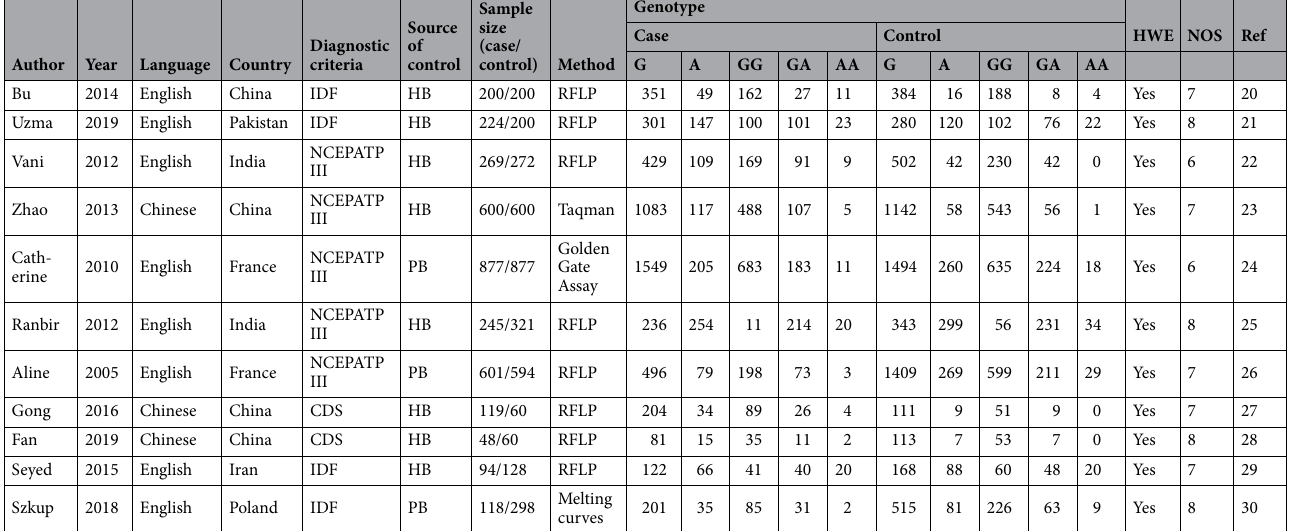
Table 1. General characteristics of studies included in the meta-analysis. HB hospital based, PB population based, IDF the International Diabetes Federation, NCEPATP III the National Cholesterol Education Program Adult Treatment Panel III, HWE Hardy–Weinberg Equilibrium, CDS Chinese Diabetes Society, RFLP restriction fragment length polymorphism, NOS Newcastle–Ottawa